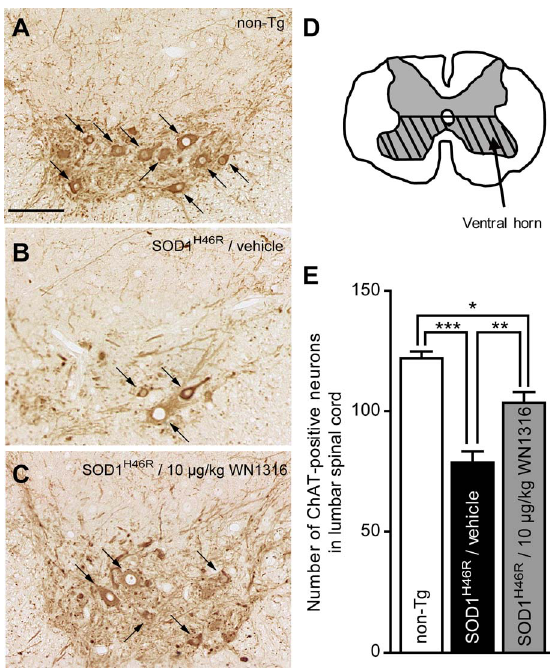
Figure 5. The WN1316 treatment slows motor neuron loss in the spinal cord. (A–C) Immunohistochemical analysis of paraffin embedded sections of the lumbar spinal cord (L4–L5) from non-Tg (A), vehicle-treated ALS(SOD1 H46R ) (B), and 10 m g/kg WN1316-treated ALS(SOD1 H46R ) (C) mice at 21–22 weeks of age (late symptomatic stage). Representative images of immunostaining with ChAT for the anterior horn are shown. Arrows indicate ChAT-positive motor neurons. Scale bar indicates 100 m m. (D) The number of the neurons within the hatched region of the cross-sectional L4–L5 segment in the lumbar spinal cord was counted. (E) The total number of ChAT-positive neurons ( . 200 m m 2 ) within the ventral half of the gray matter (hatched region shown in D) in the lumbar spinal cord (L4–L5) of non-Tg (n=4), vehicle- treated ALS(SOD1 H46R ) (n=4), and 10 m g/kg WN1316-treated ALS(- SOD1 H46R ) (n=4) mice. Data are expressed as mean 6 SEM. * p , 0.05, ** p , 0.01 or *** p , 0.001 by one-way ANOVA with Bonferroni’s post hoc